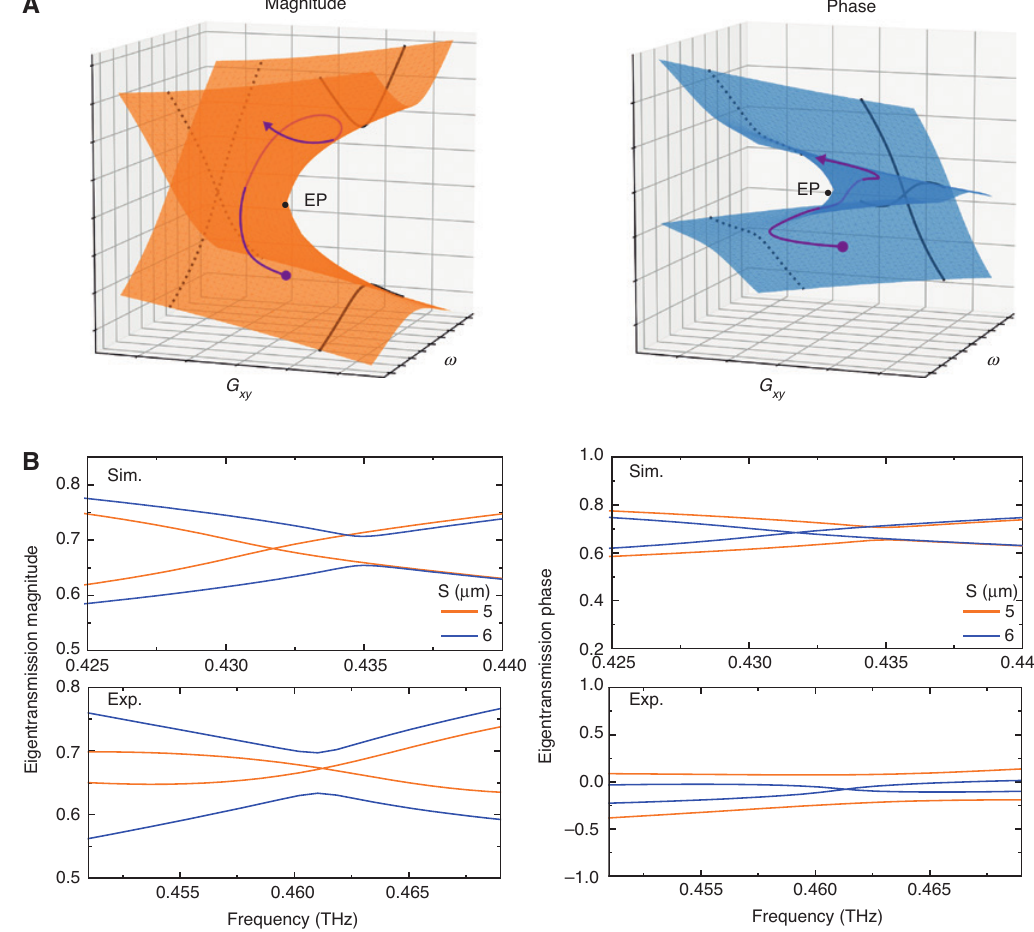
Figure 2: Eigenvalue surface topology near an exceptional point revealed through transmission simulation and experiment results of the non-Hermitian